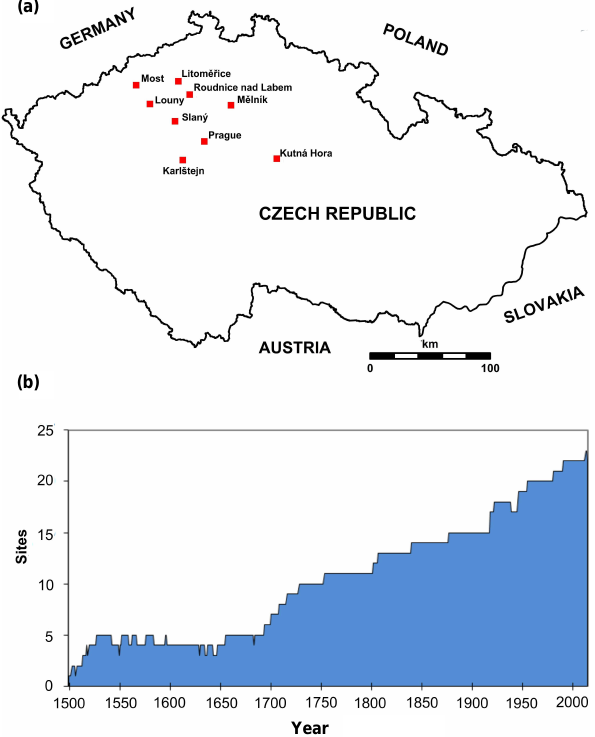
Figure 1. (a) Map of the Bohemian wine-growing region; (b) the number of sites of grape-harvest observations per year for the 1499– 2015 period in individual